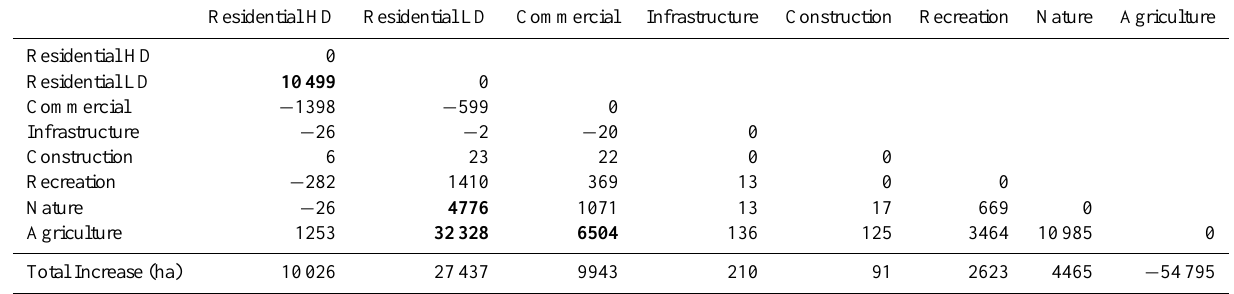
Table 6. Matrix of net changes (in hectares) among the respective land use types between 2000 and 2030 GE.